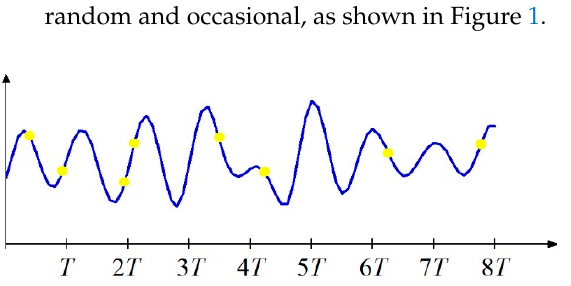
Figure 1. Random missing. The yellow dots represent missing data.